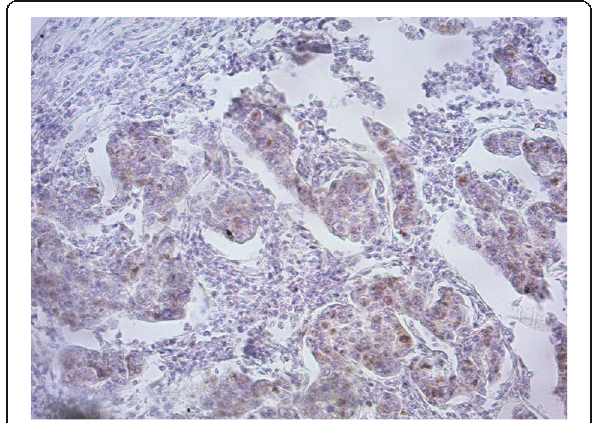
Fig. 1 Invasive breast cancer tissue with non-specific